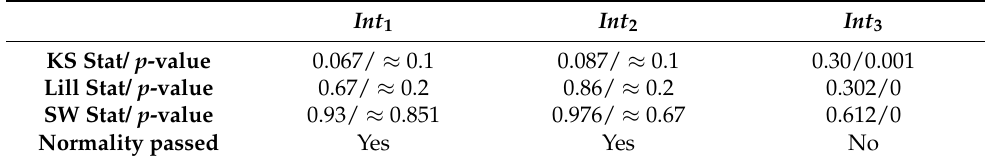
Table 5. Results of normality testing for Int 1 , Int 2 , Int 3